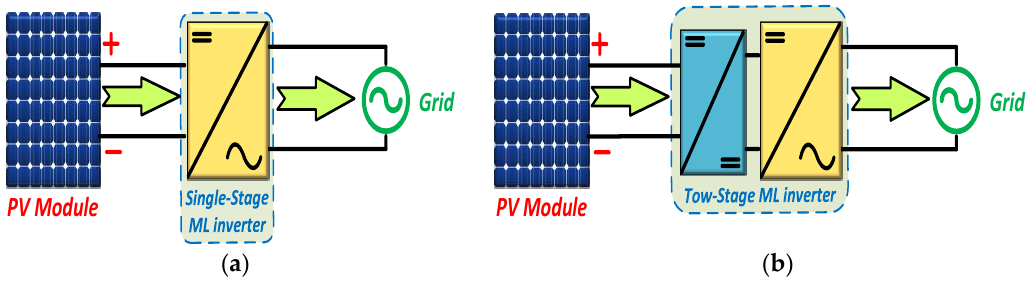
Figure 2. Inverter types ( a ) single-stage inverter, ( b ) two-stage inverter